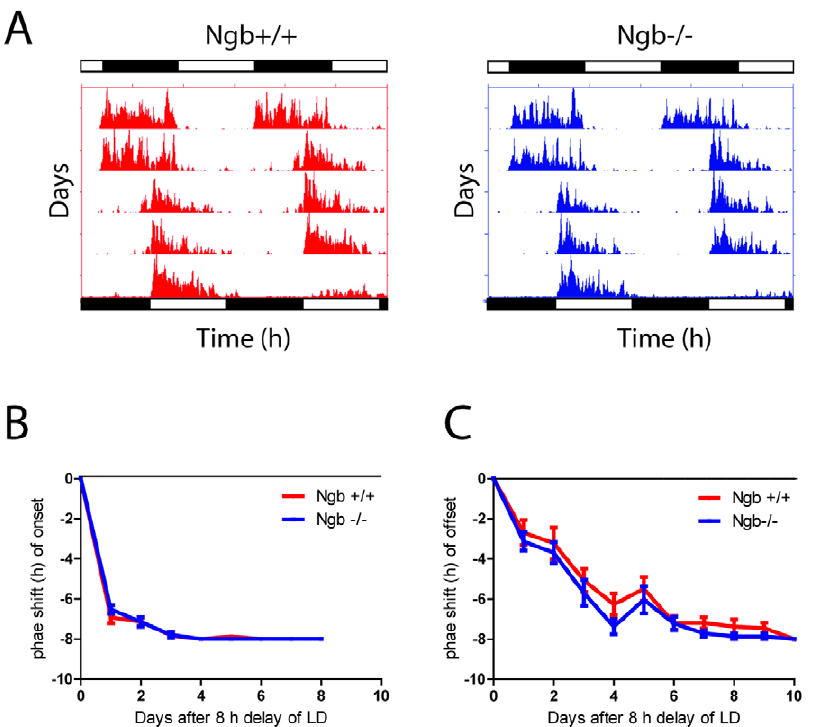
Figure 3. Re-entrainment after eight h phase shift of the LD cycle (jetlag) in Ngb deficient mice. A . Representative actogram of Ngb wild type (red) and Ngb deficient mice (blue) entrained to a 12:12 h LD cycled followed by a eight h shift (delay) of the LD cycle. Bars in top of each actogram represent the LD cycle before the shift, the bars below the LD cycle after the shift. B . Quantitative analysis of the eight h phase delay of the LD cycle using the onset as phase marker (n=7 of each genotype). Note that both groups re-entrain within three cycles. C . Quantitative analysis of the eight h phase delay of the LD cycle using the offset as phase marker (n=7 of each genotype). Note both groups re-entrain within seven cycles.